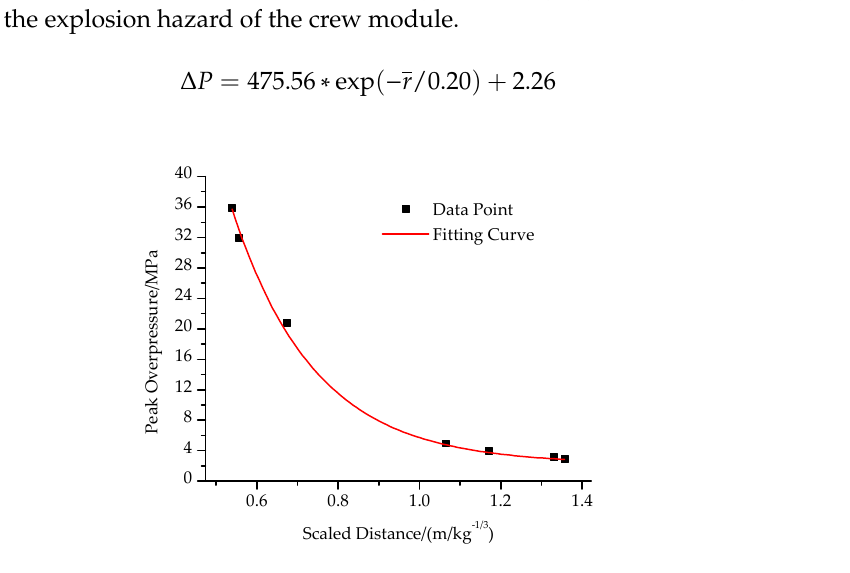
Figure 9. Fitting curve of the peak overpressures of blast wave versus scaled distances.